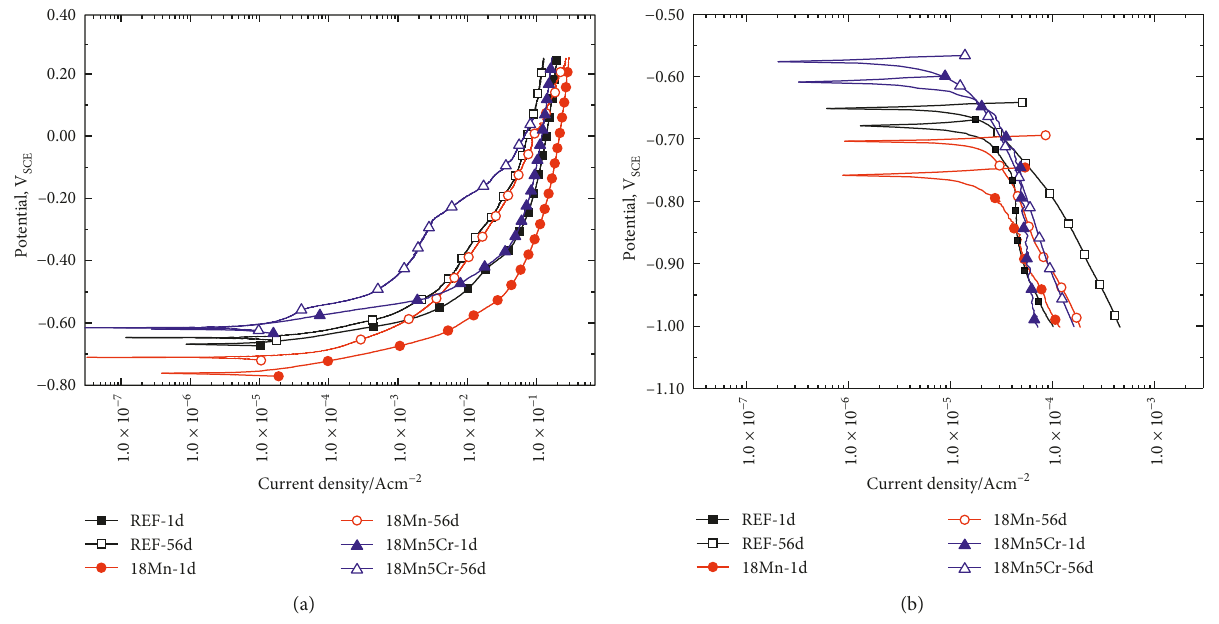
Figure 2: Anodic (a) and cathodic (b) polarization curves of experimental alloys in 3.5% NaCl solution at 60 °